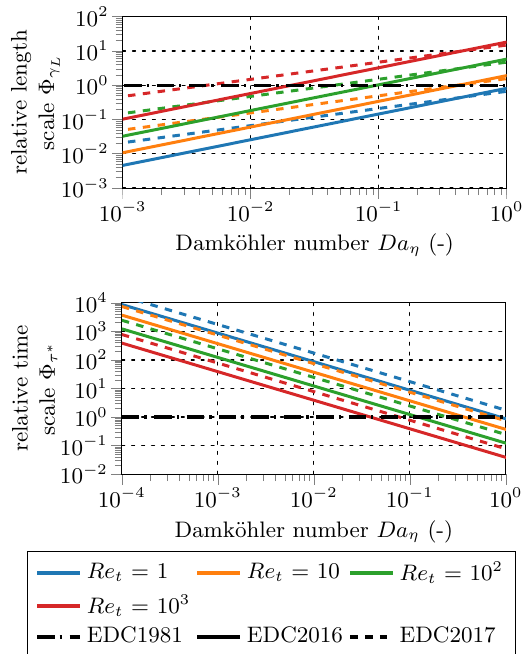
Figure 3. Comparison of the fine structure share ( top ) and the fine structure residence time ( bottom ) as functions of the Damköhler number at Kolmogorov scale ( Da η ) and turbulent Reynolds number ( Re t ) of the EDC2016 and EDC2017 normalized by the results using the